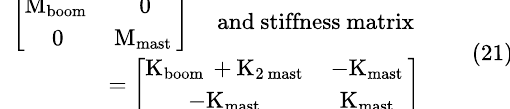
The characteristics equation of the motion of the tower crane is given